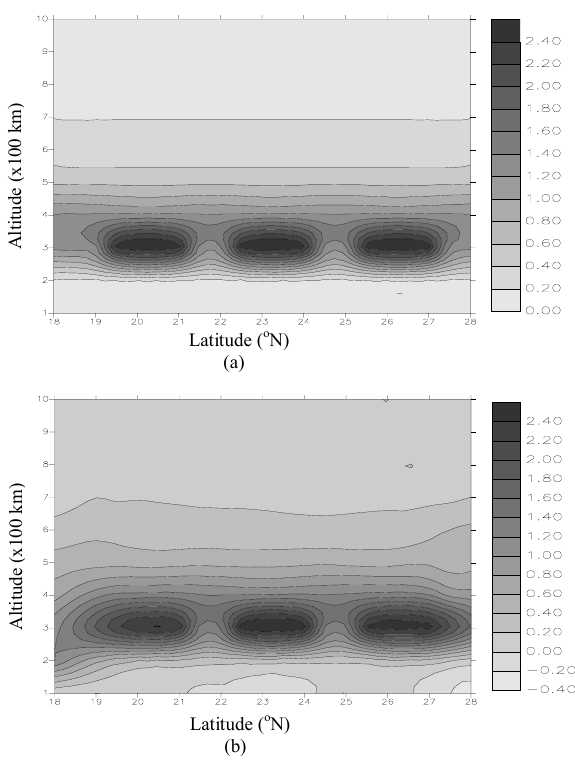
Fig. 2. ( a ) Model ionosphere with complicated irregularities (elec- tron density in units of 10 6 cm − 3 ) ( b ) Reconstruction of the model ionosphere of Fig.